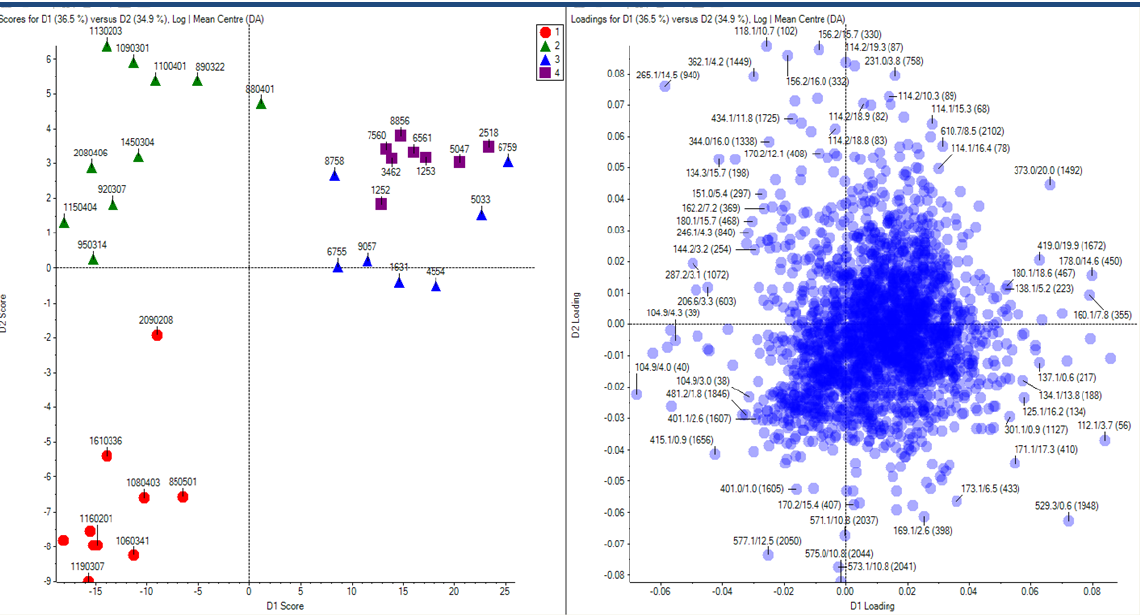
Figure 10. PCA-DA plot of the PKD HILIC-LC–ESI–MS before feature selection. Groups were color-coded as: 1-red: female PKD, 2-green: male PKD, 3-blue: female control, 4-purple: male control. Total 35 samples, 2,288 predictors.